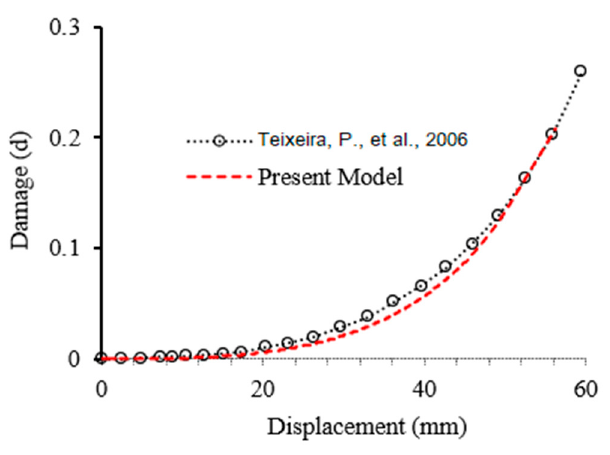
Figure 4. Bulge test damage distribution (isotropic damage model).